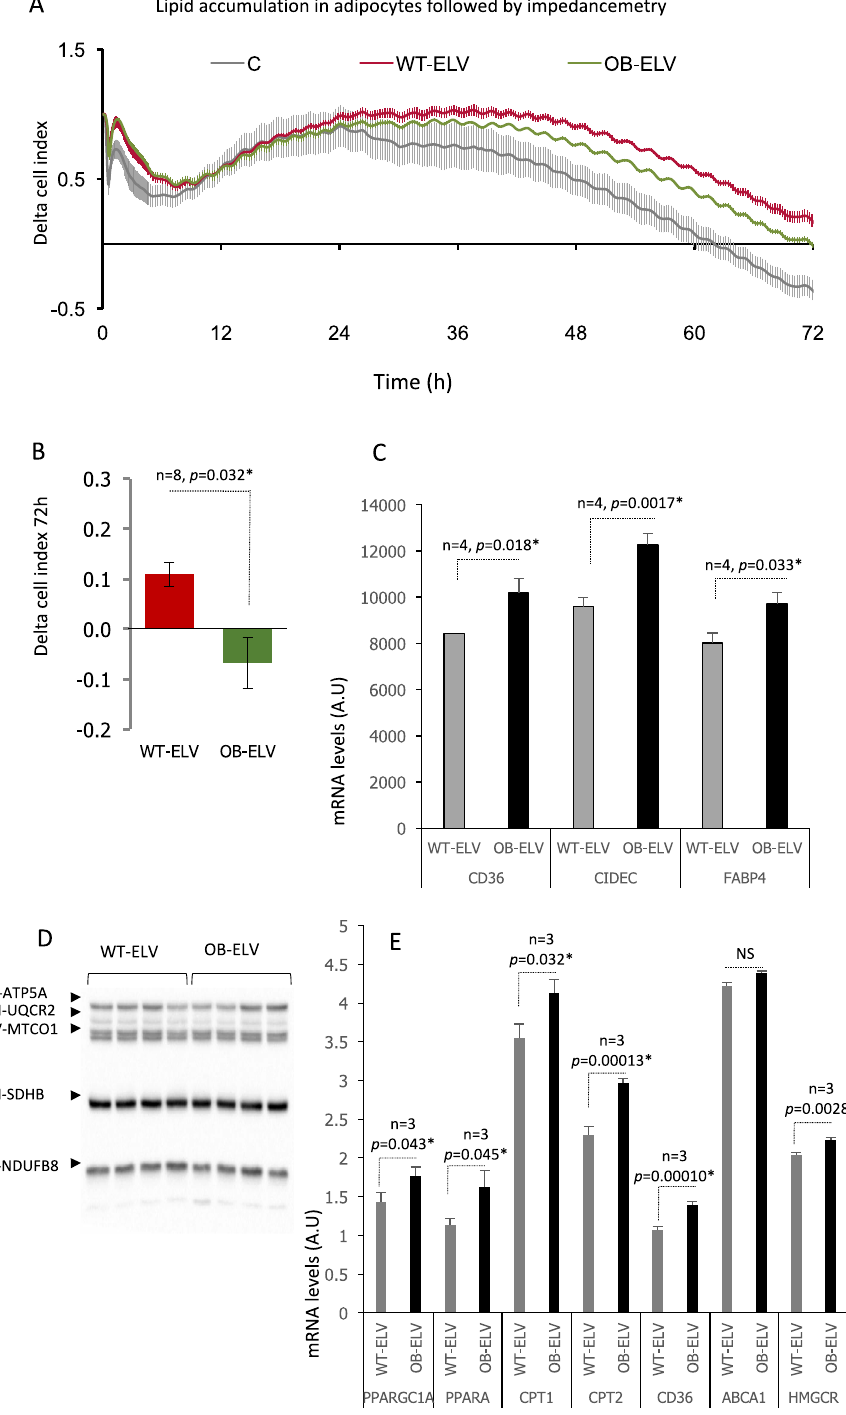
Figure 6. OB-ELVs modulate lipid storage in recipient cells. ( A ) 3T3-L1 cells were grown and differentiated in 96-wells E-plates and then maintained in DMEM/5% FBS vesicle-free for 2 h before treatment with OB-ELVs or WT-ELVs. Untreated adipocytes were used as control. The curves represent real-time monitoring of the cell index substracted from the cell index at T = 0 (mean delta cell index, every 5 min during 50 cycles then every 15 min) for 72 h. ( B ) Slopes at T = 72 h (mean values + /- SEM) (n = 8). ( C ) mRNA levels of genes involved in lipogenesis in differentiated adipocytes at T = 72 h post treatment with OB-ELVs or WT-ELVs. ( D ) Western-blot showing the oxphos proteins in C2C12 treated for 24 h with OB-ELVs or WT-ELVs (the full gel is shown). ( E ) mRNA levels of genes involved lipid metabolism in C2C12 treated for 24 h with OB-ELVs or WT-ELVs. For all figures, * = significant p -values ( p < 0.05, student t